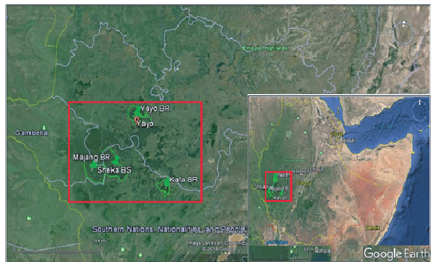
Figure 2: Map of the biosphere reserves in Southwestern